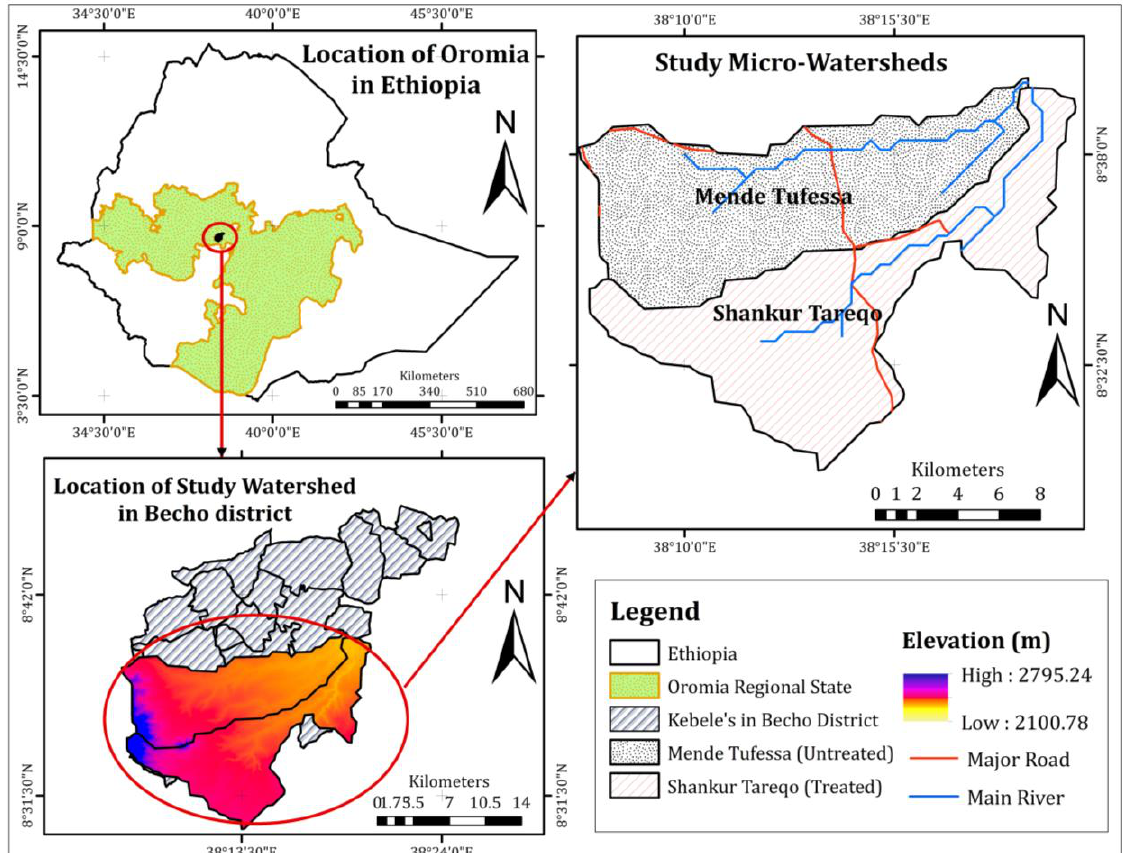
Fig. 1. Location map of Shankur Tareqo and Mende Tufessa watersheds, in Becho